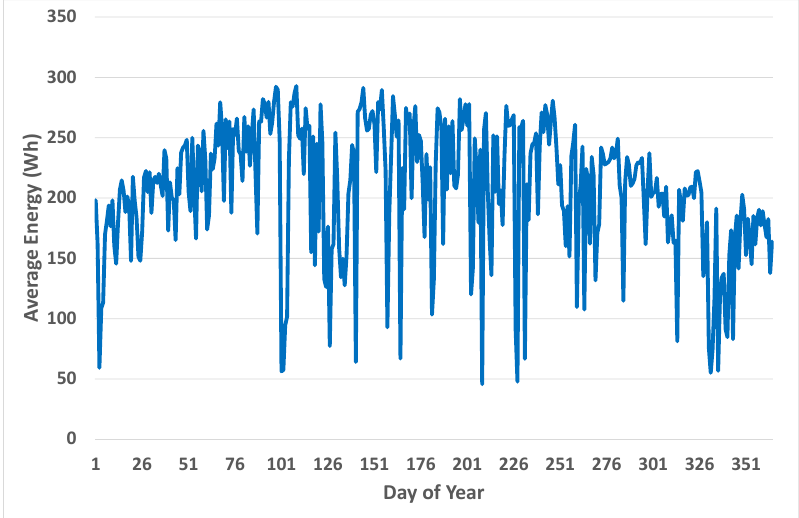
Figure 9. Daily mean solar radiation for